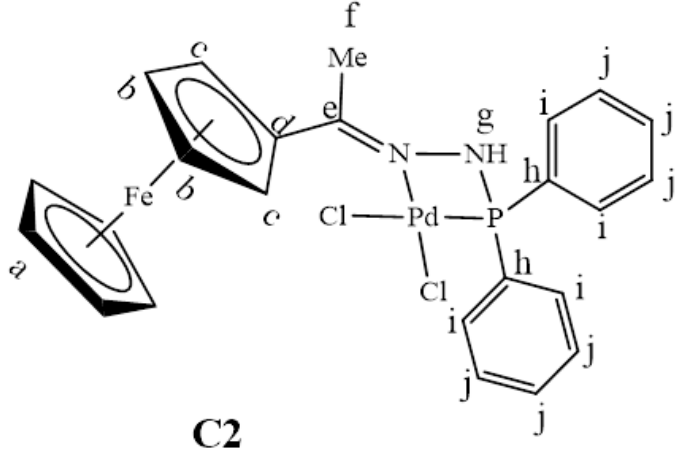
Figure 28. The chemical structure of C2 .